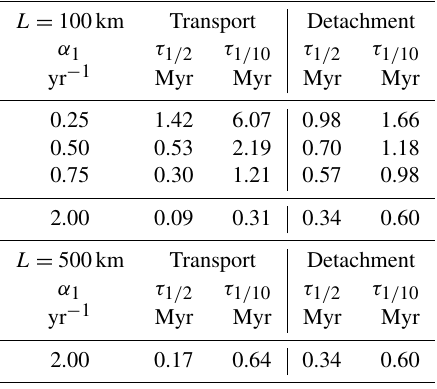
Table 2. Response to a change in precipitation rate; α 1 repre- sents the value that the precipitation rate changes to from α 0 = 1mmyr − 1 . Response time is given for two model sizes, 100 and 500km, and as the time for the model to recover to within 50% (1 / 2) and 10% (1 / 10) of the steady-state sediment flux. L = 100km